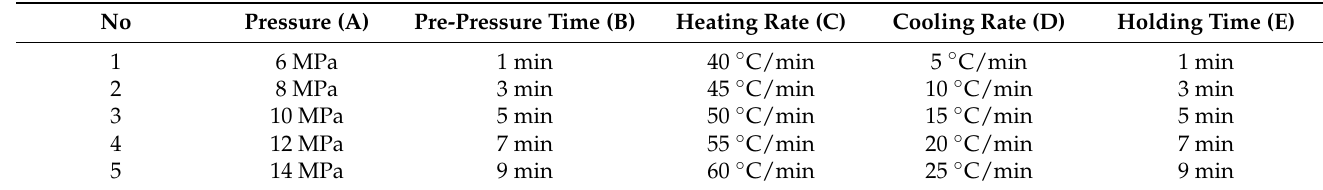
Table 1. The parameters and the levels.